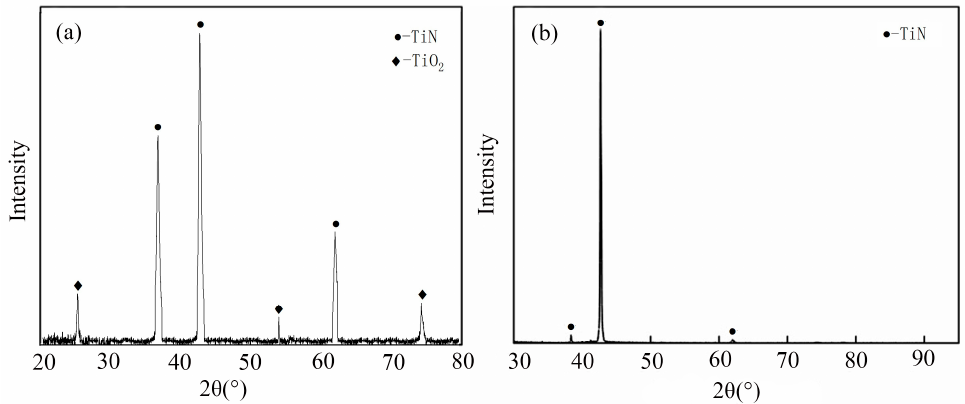
Figure 3. XRD spectra: ( a ) black powders; ( b ) point B of Figure 2a.